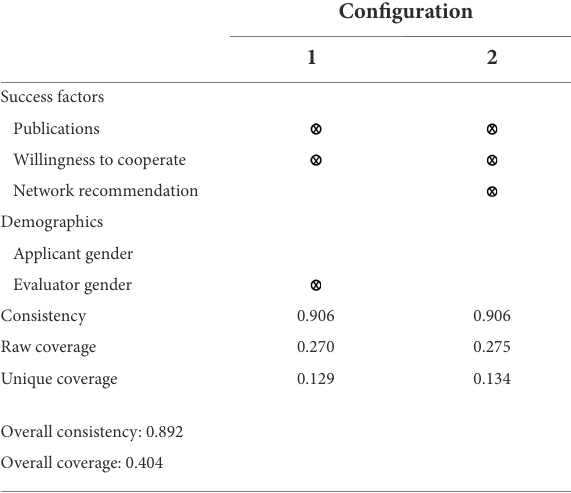
TABLE 3 Configurations leading to low selection